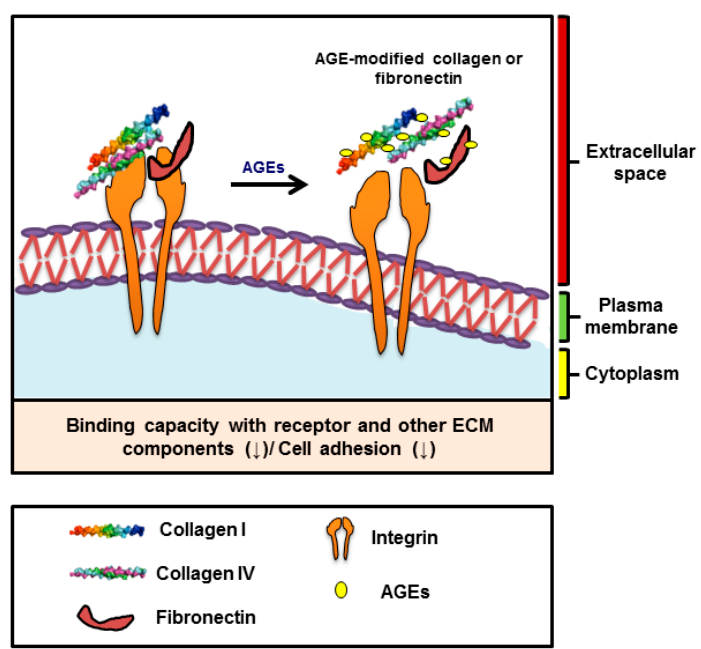
Figure 2. Modifications of ECM components by advanced glycation end products (AGEs) and their effects.